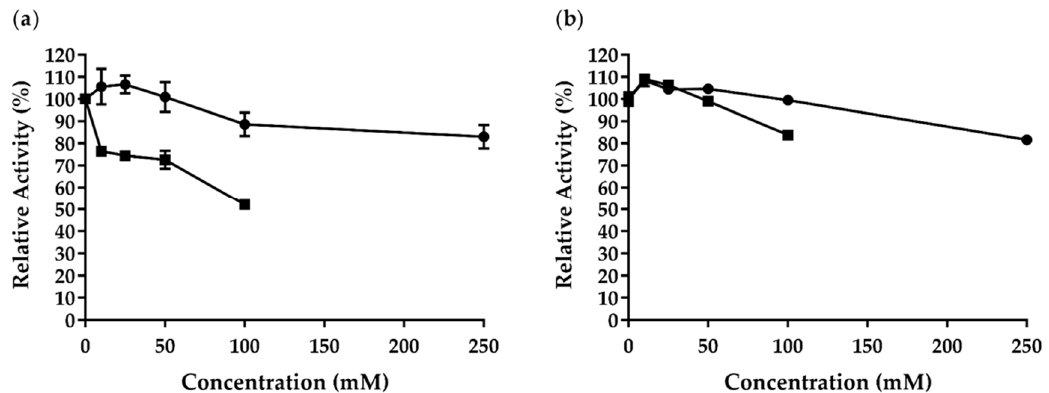
Figure 6. • Glucose and (cid:4) cellobiose effects on ( a ) Af Cel6A and ( b ) Af AA9_B activity. Figure 6. ● Glucose and ■ cellobiose effects on ( a ) Af Cel6A and ( b ) Af AA9_B activity.